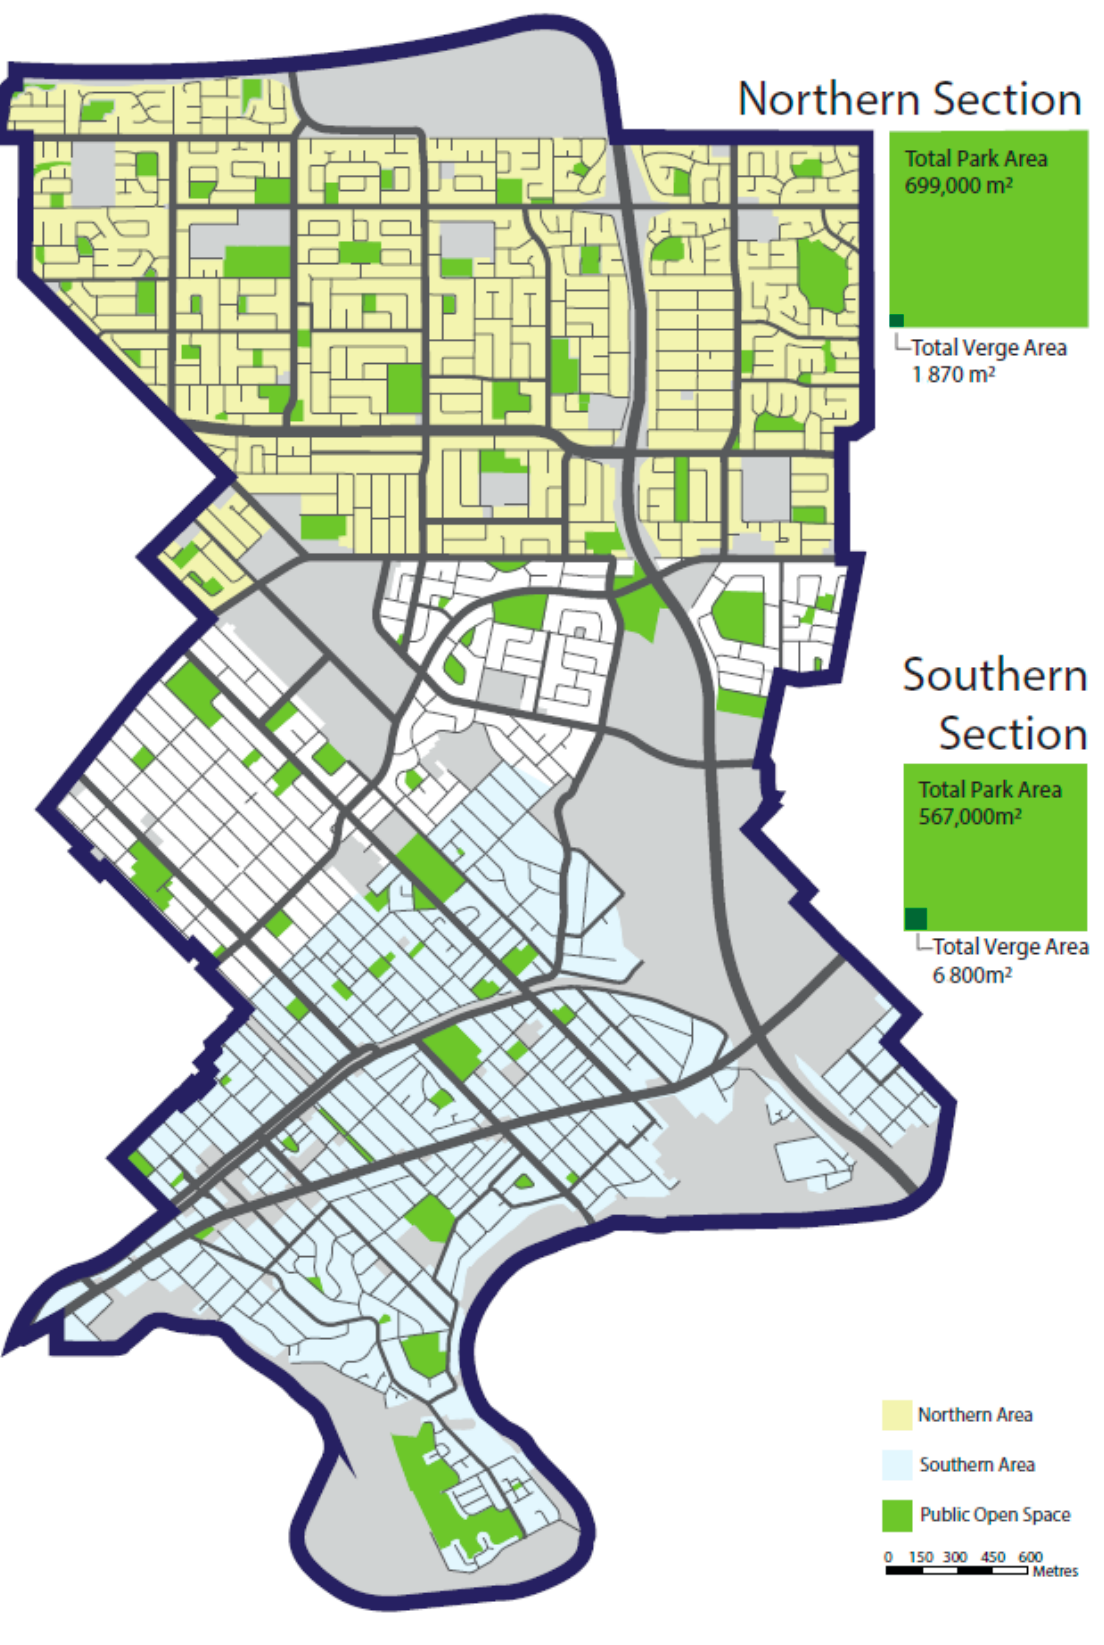
Figure 11. Collective public open space within the City of Bayswater.